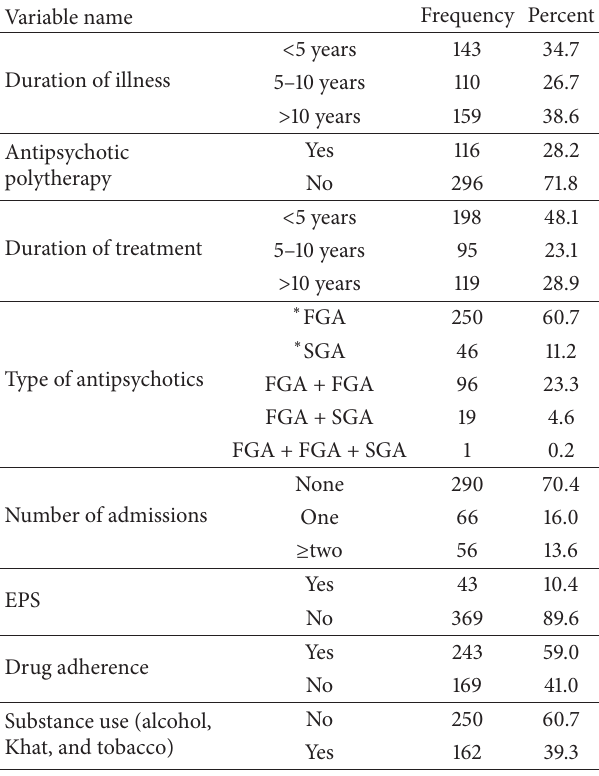
∗ FGA: first generation antipsychotics. ∗ SGA: second generation antipsy-